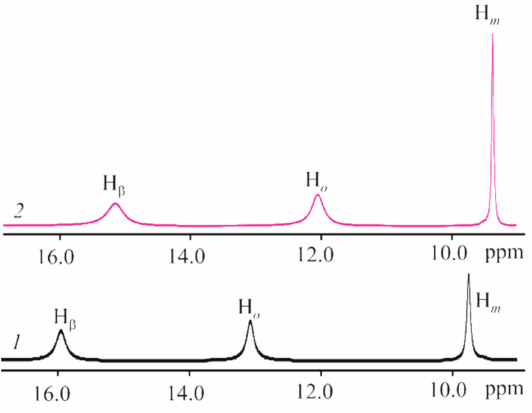
Figure 7. The 1 H NMR spectra of CoTTP ( 1 ) and its triad, (PyC 60 ) 2 CoTTP ( 2 ) in CDCl 3